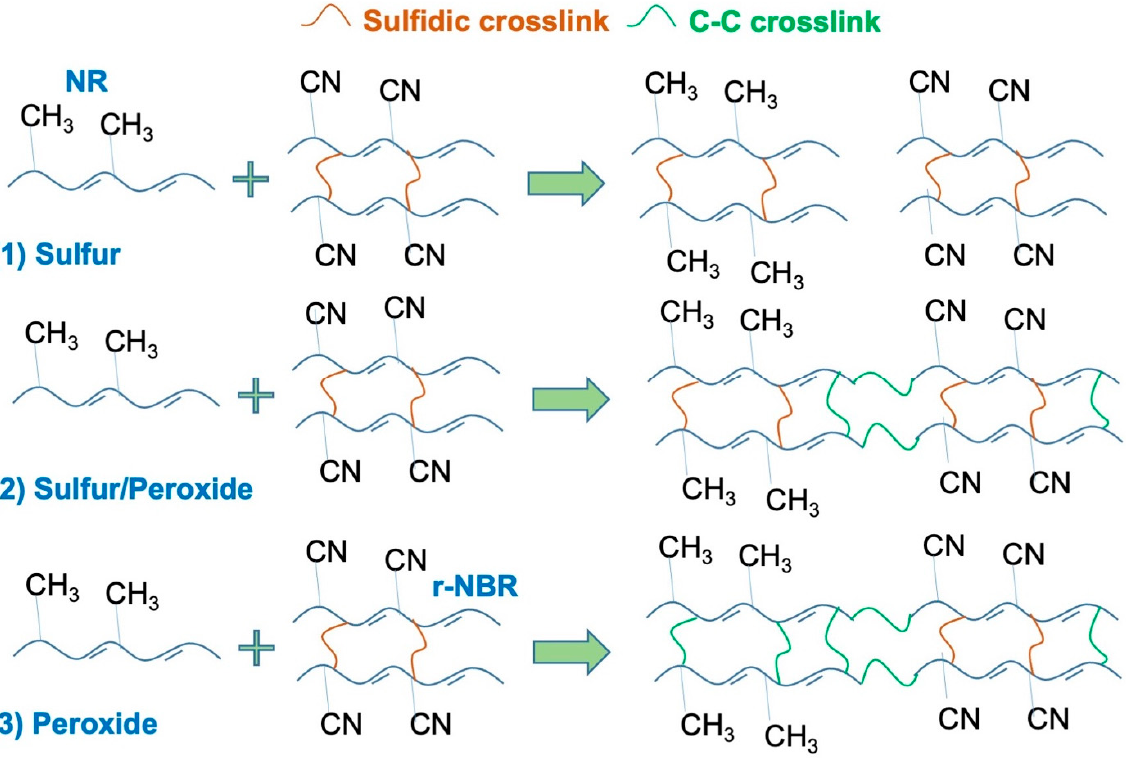
Figure 4. Schematic illustration of crosslinks observed in the blends.